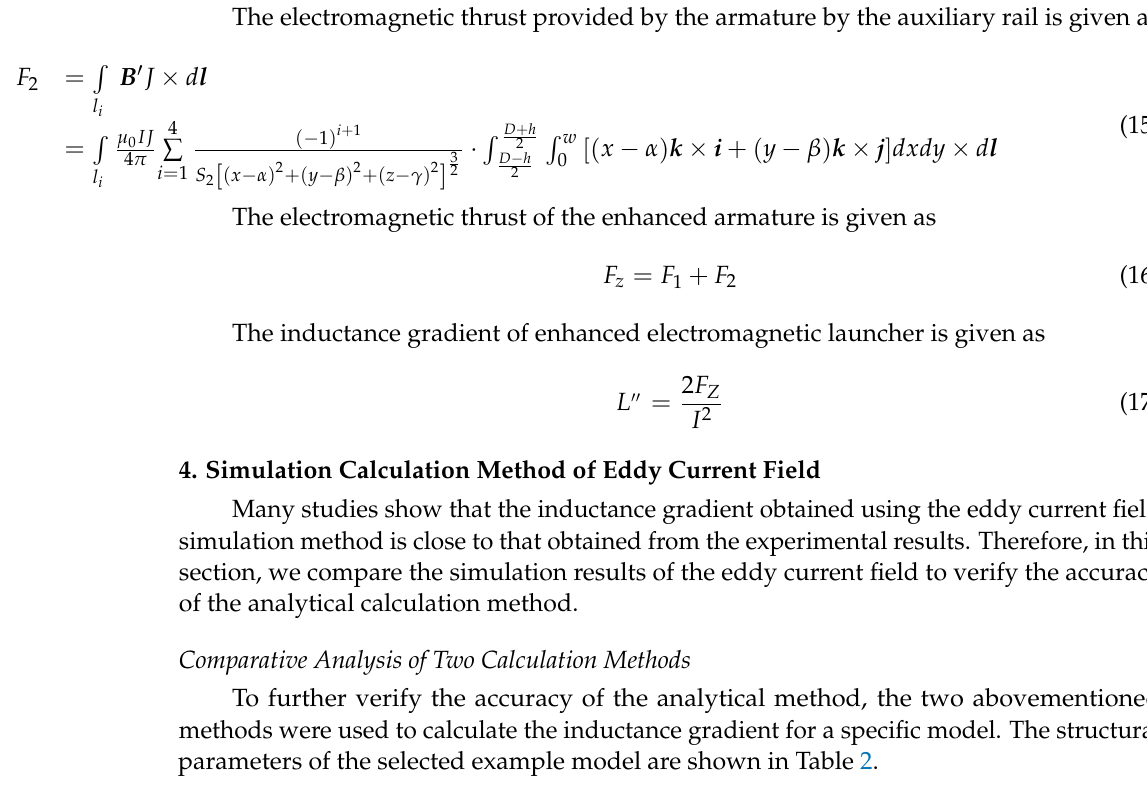
Table 2. Structural parameters of calculation example.